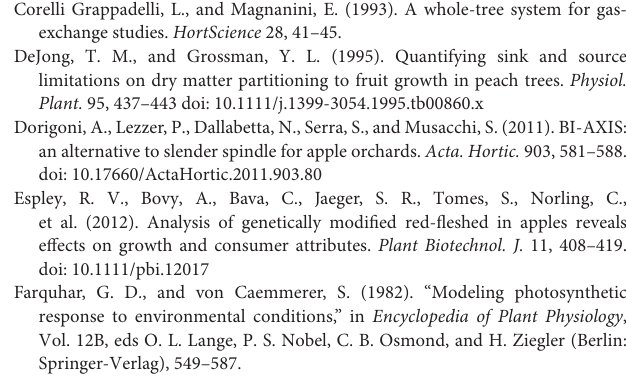
Figure S1 | Mean ( ± Standard Error, SE) midday stem water potential (SWP) considering the plant type (Homogeneous ‘Hosui’ (HH), Homogeneous ‘PremP009’ (HP) and Mixed (M)). Each bar represents the mean ± SE of 12 replicates of the three plant types. Treatments were separated with a one-way ANOVA and compared by the Student-Newman-Keuls test. Figure S2 | Relationship between final tree dry weight and total leaf area of ‘PremP009’ and ‘Hosui’ homogenous plant (H P and H H ) and mixed plant (M). Each point represents an entire